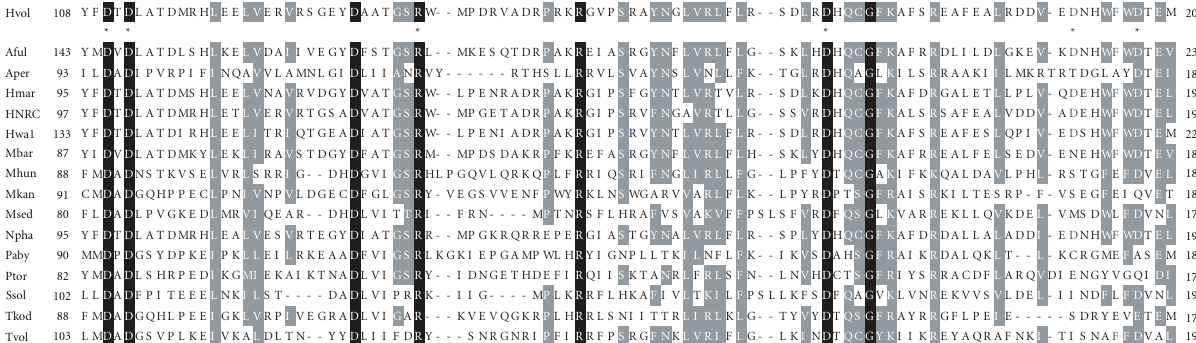
Figure 2: Conserved residues in archaeal AglD proteins. The sequences of Hfx. Volcanii AglD (accession number AM698042) and AglD homologues in Archaeoglobus fulgidus (NP 069415.1; Aful), Aeropyrum pernix (NP 147774.1; Aper), Haloarcula marismortui (YP 136461.1; Hmar), Halobacterium sp. NRC-1 (NP 279416.1; HNRC), Haloquadratum walsbyi (YP 657261.1; Hwal), Methanosarcina acetivorans (NP 618739.1; Mace), Methanosarcina barkeri (YP 304067.1; Mbar), Methanospirillum hungatei (YP 503949.1; Mhun), Methanopyrus kandleri (NP 614163.1; Mkan), Metallosphaera sedula (YP 001191894; Msed), Natronomonas pharaonis (YP 326773.1; Npha), Pyrococcus abyssi (NP 127133.1; Paby), Picrophilus torridus (YP 024256.1; Ptor), Sulfolobus solfataricus (NP 342803.1; Ssol), Thermococcus kodakarensis (YP 182777.1; Tkod), and Thermoplasma volcanium (NP 111403.1; Tvol) were aligned by ClustalW2 (www.ebi.ac.uk/Tools/clustalw2/index.html), using the default settings. The region of the highest similarity is shown. Completely conserved residues are shown against a black background, while largely conserved residues (i.e., similar residues conserved in at least 11 sequences) are shown against a grey background. Amino acid numbers are shown at the start and end of each sequence. Asterisks are placed under Hfx. volcanii AglD D110, D112, R139, D173, D195, and D201 (see text for details).